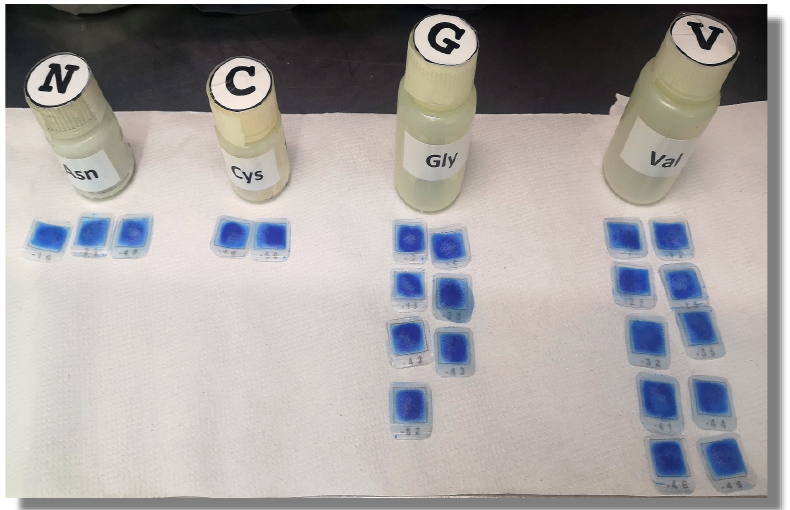
Figure 5. Distribution of the tea bags according to the amino acid to be coupled, after washing with bromophenol blue.